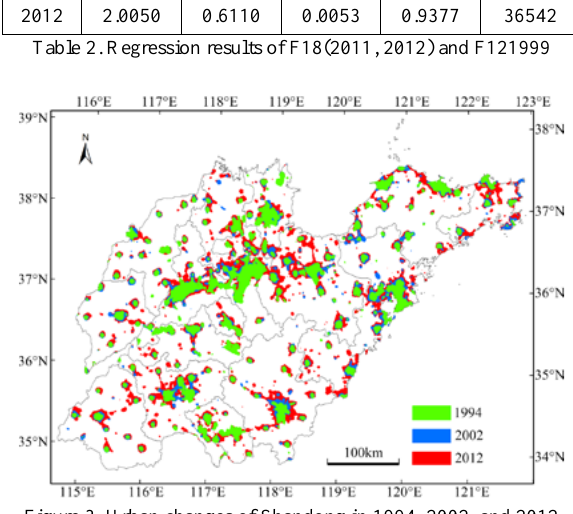
Figure 2. Regression results of F18(2011, 2012) and F121999